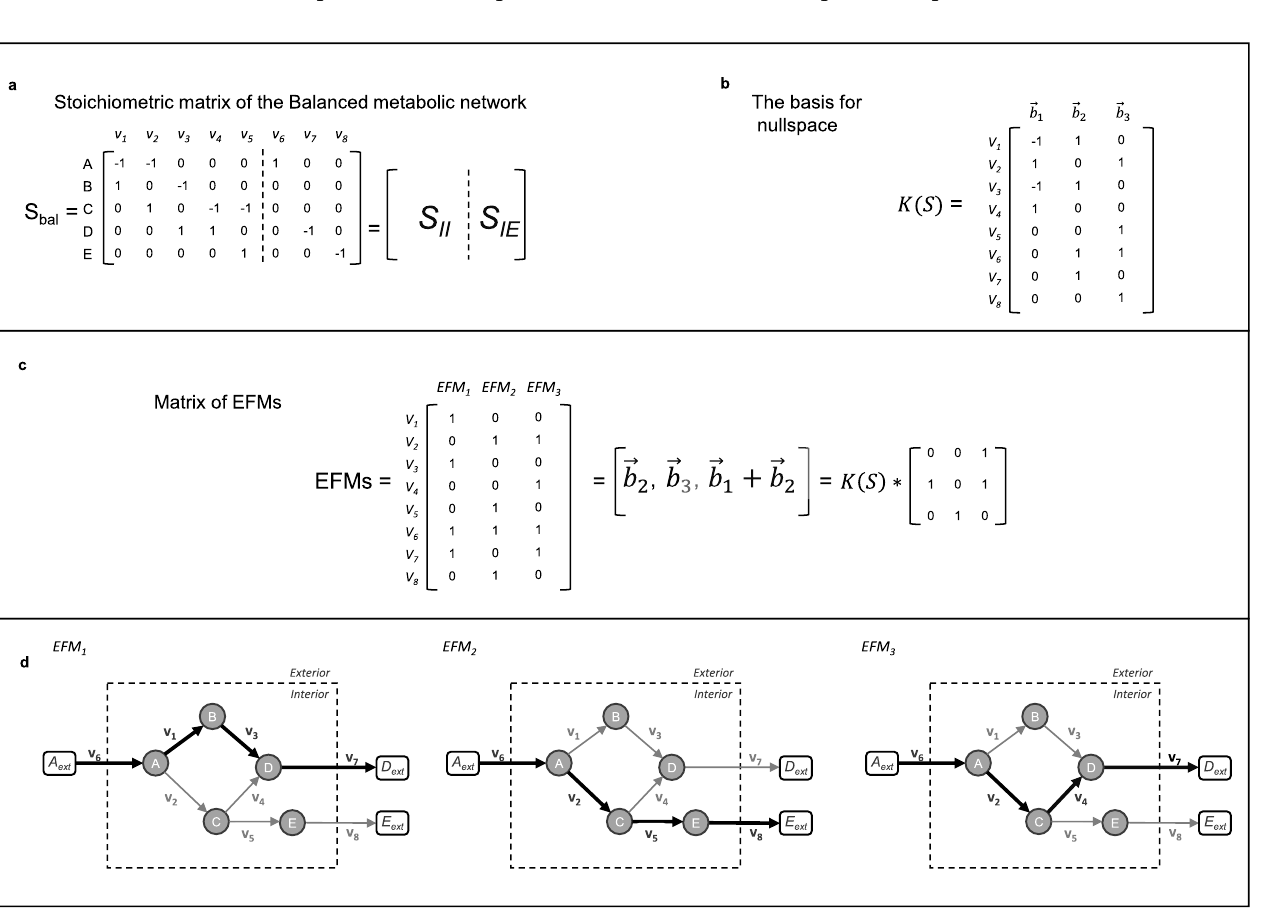
Figure 3. Metabolic pathway analysis ( a ) The balanced metabolic network includes the metabolites for which the quasi- steady state assumption holds. ( b ) The basis for the null space is the kernel matrix of the stoichiometric matrix. ( c ) Elementary flux modes (EFMs) are enumerated assuming that all the reactions are irreversible. Each EFM is a linear combination of the basis vectors. ( d ) The flux maps for the EFMs are shown on the substrate graph of the network (see Figure S1, Supplementary Material, for the network of reversible